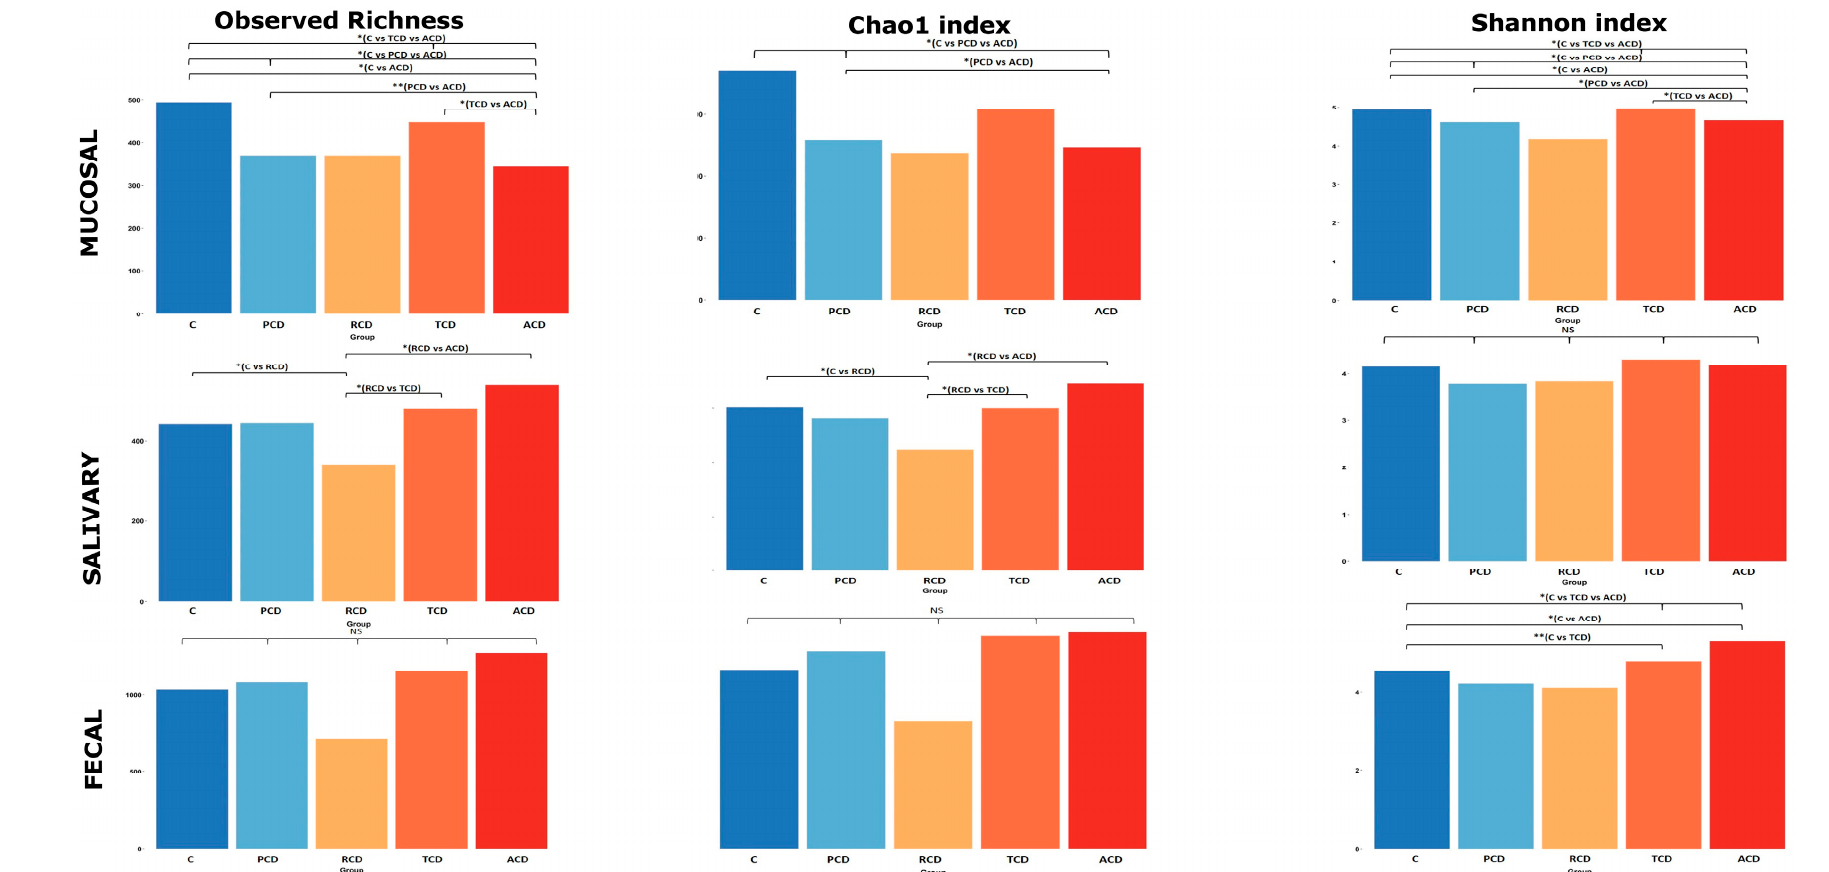
Figure 3. Alpha-diversity: Overall comparison of mucosal, salivary, and fecal microbiota structure. Observed richness and the Chao1 (representing community richness) and Shannon (representing diversity) indices are presented. The bars depict the mean of relative abundances rates. Significant (* p < 0.05; ** p < 0.01) comparisons between patient categories are indicated over the bars.